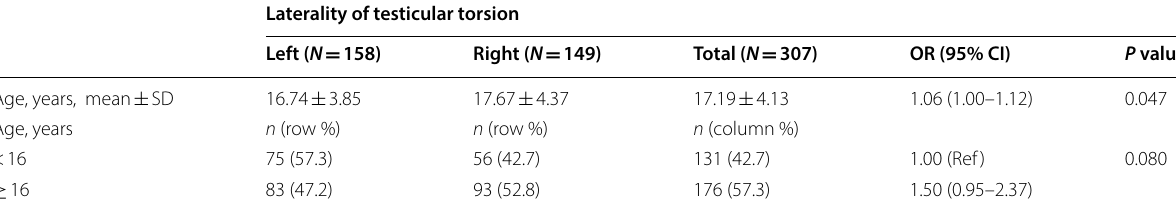
Table 2 Association of age with laterality of testicular torsion Laterality of testicular torsion